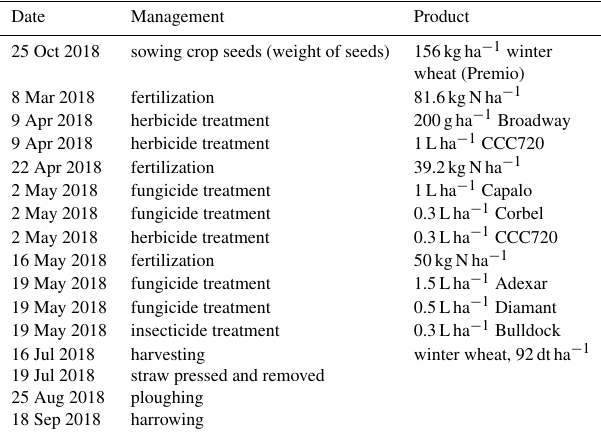
Table A1. Management activities on the test site over the winter wheat cultivation cycle before, during, and after the observation pe- riod of the CloudRoots